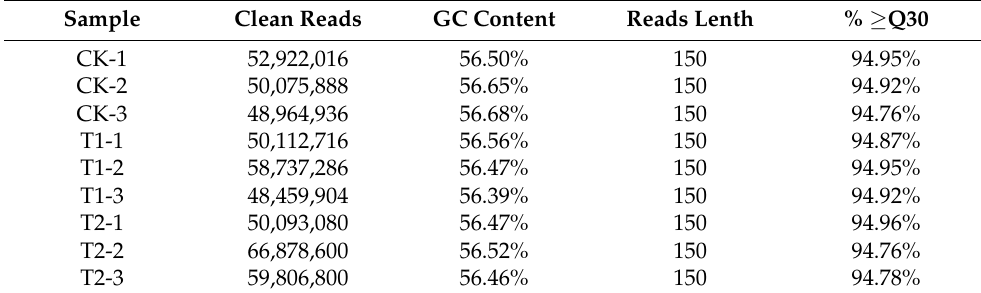
Table 4. Sequencing data statistics of the nine samples.